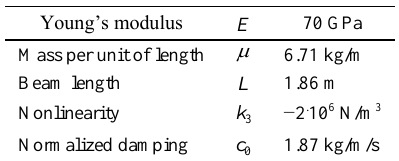
Characteristics of the beam